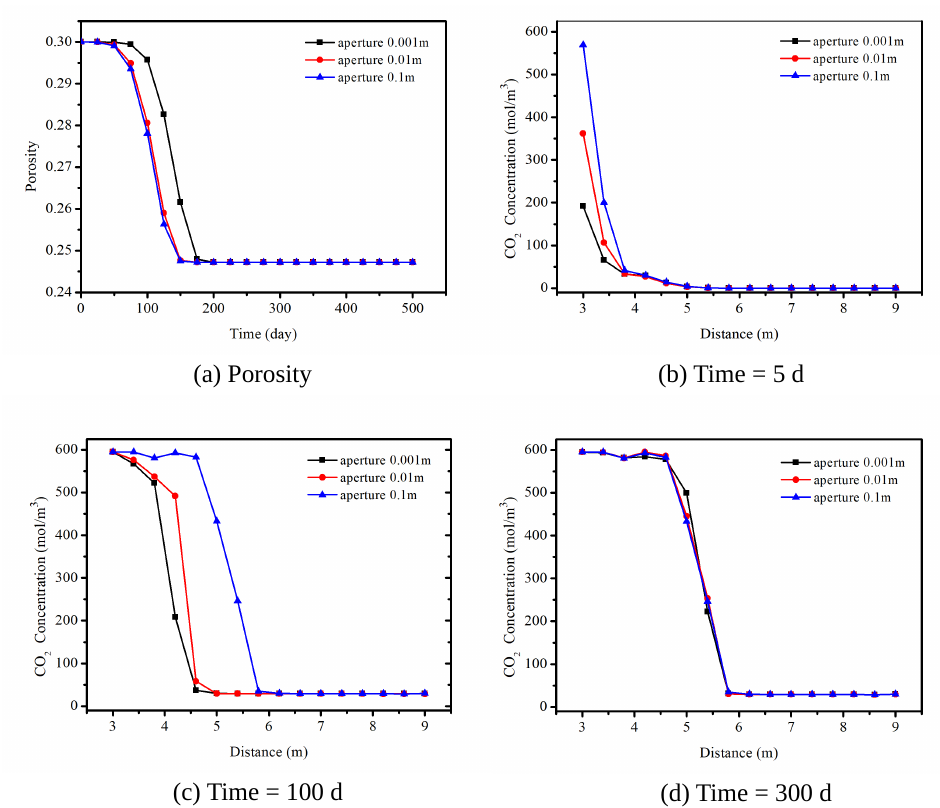
Figure 7. Influence of fracture aperture on CO 2 sequestration; ( a ) the variation of porosity with time; ( b – d ) the variation of CO 2 concentration with distance on five days, 100 days, and 300 days.